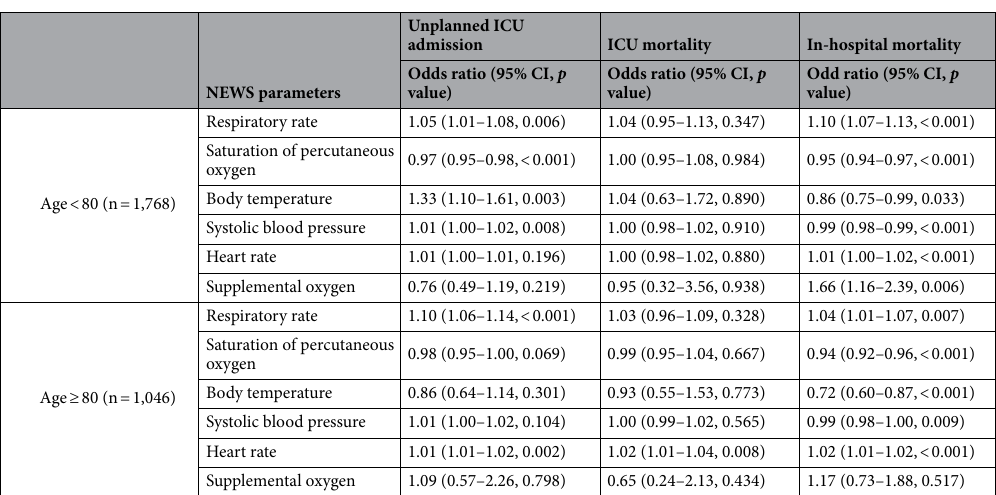
Table 3. Sensitivity analysis for effects of raw National early warning parameters on severe outcomes by age group. NEWS National early warning score, ICU intensive care unit, CI confidence